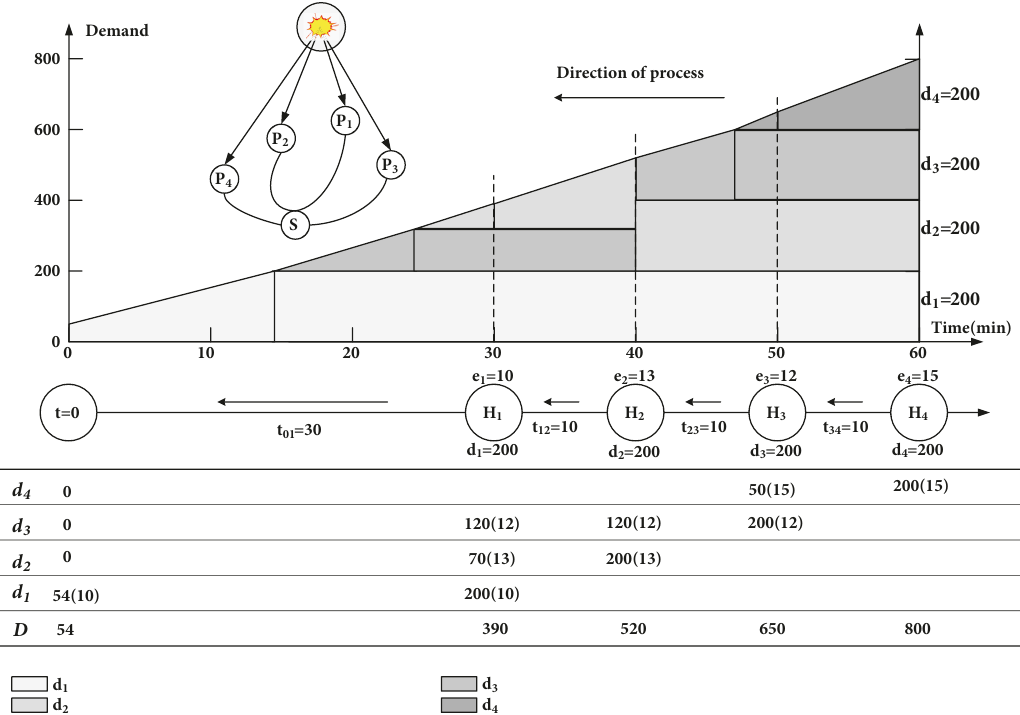
Figure 8: Illustration of solution algorithm of